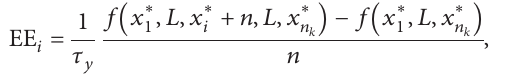
Figure 2: Reservoir mesh diagram and boundary